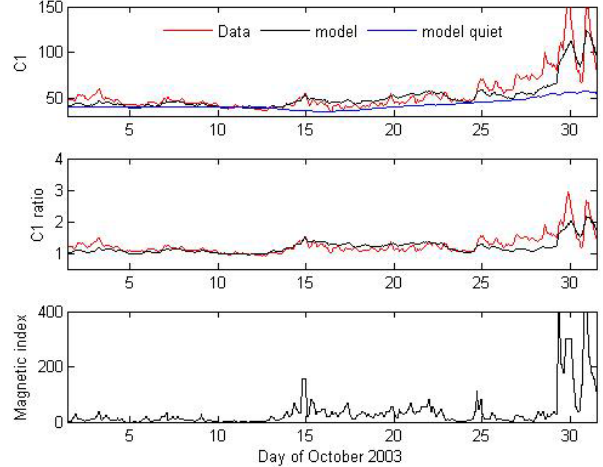
Fig. 7. Variations with UT of the c 1 projection coefficients for the NS orbit segments during May 2003. Upper panel: variations of the CHAMP density c 1 projection co- efficient (red line) and those computed with the actual (black line) and quiet (blue line) NRLMSISE-00 models using Mg II instead of F10.7 as a proxy for the solar activity. Middle panel: variations of the c 1 (CHAMP)/ c 1 (NRLMSISE-00 quiet) (red line) and c 1 (NRLMSISE-00 actual)/ c 1 (NRLMSISE-00 quiet) (black line) ratios. Lower panel: variations of the a p magnetic activity index.